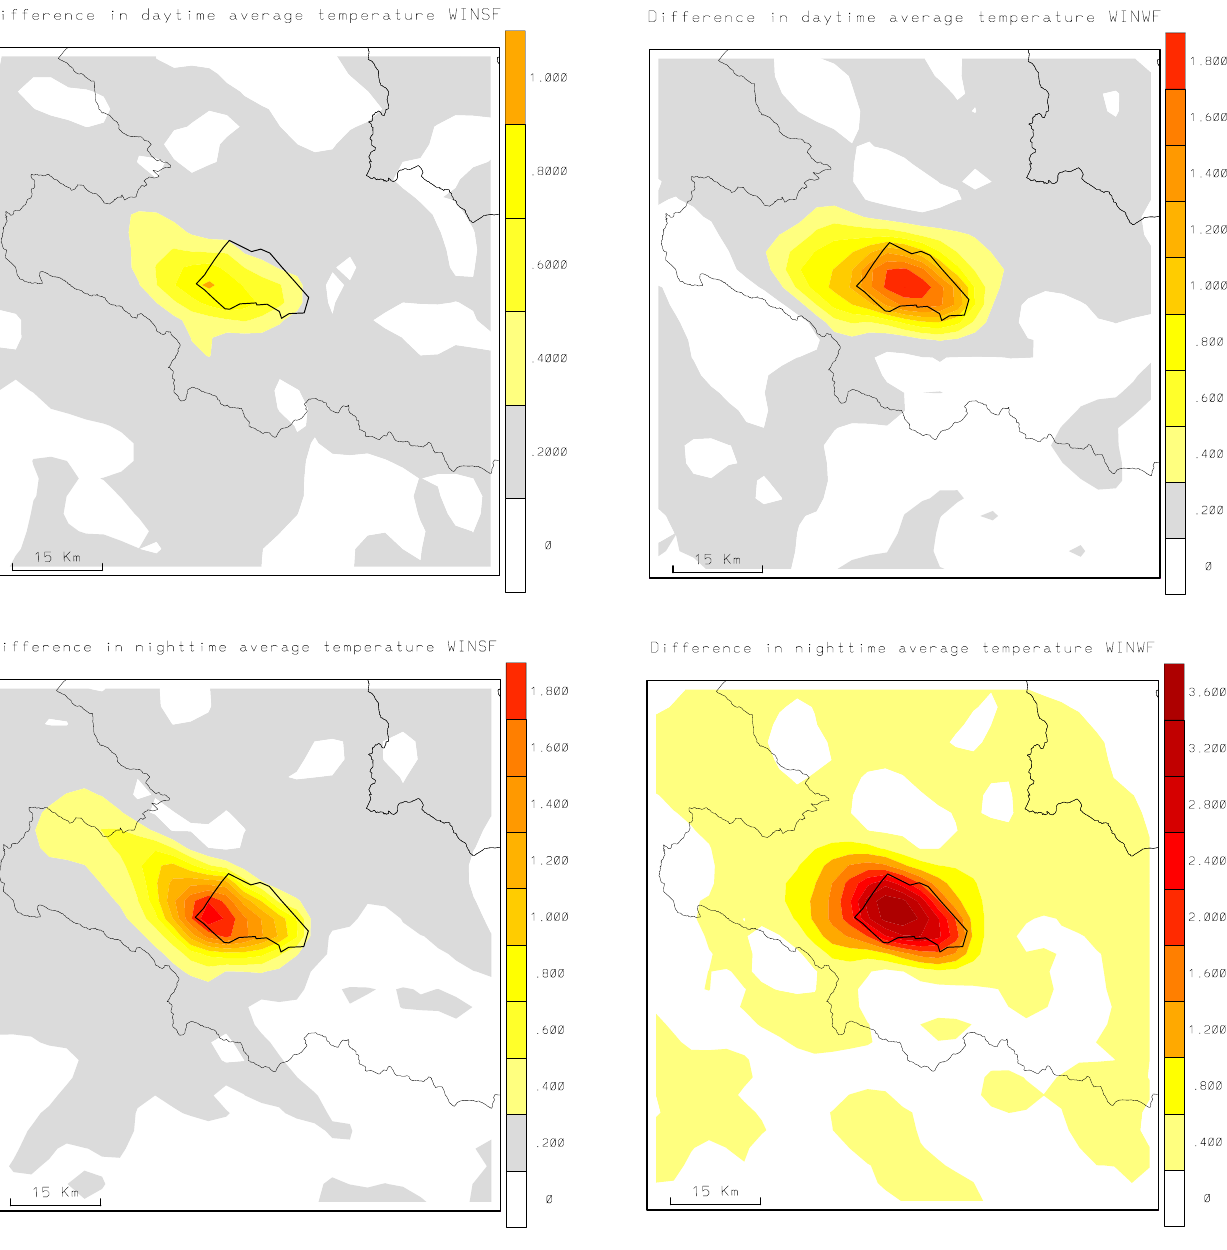
Fig. 7. Difference in daytime and nighttime average temperature between cases with the lake and without the lake. (a) WINSF, daytime; (b) WINWF, daytime; (c) WINSF, nighttime; (d) WINWF, nighttime. Units are K.